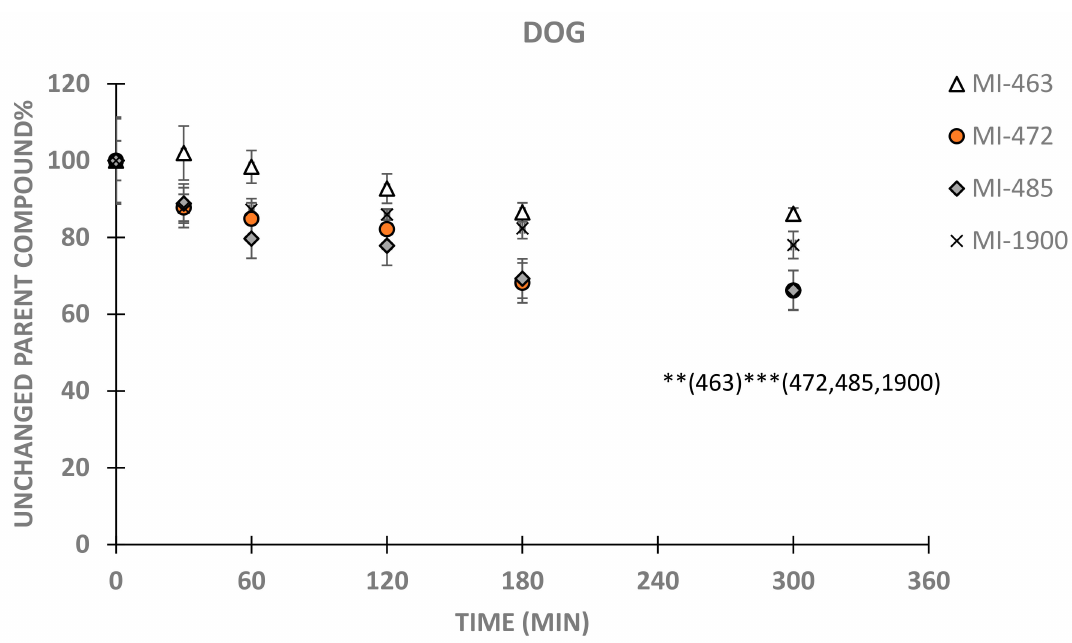
Figure 3. Time course of depletion of inhibitors MI-463, MI-472, MI-485 and MI-1900 in dog primary hepatocytes (5 × 10 5 /mL) using 0, 30, 60, 120, 180 and 300 min sampling times. Relative percentage values of unchanged parent compounds were calculated by dividing the concentrations of the inhibitor measured at given time point by mean starting MI concentration in the treatment solution (mean ± SD; n = 3–9/group). Asterisks indicate significant differences compared to starting values of the indicated inhibitors in parentheses at 300 min (** p < 0.01, *** p < 0.001).